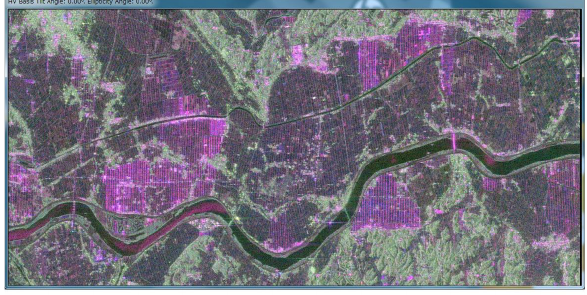
Figure 7. Pauli decomposition (R:HH G:HV B:VV)